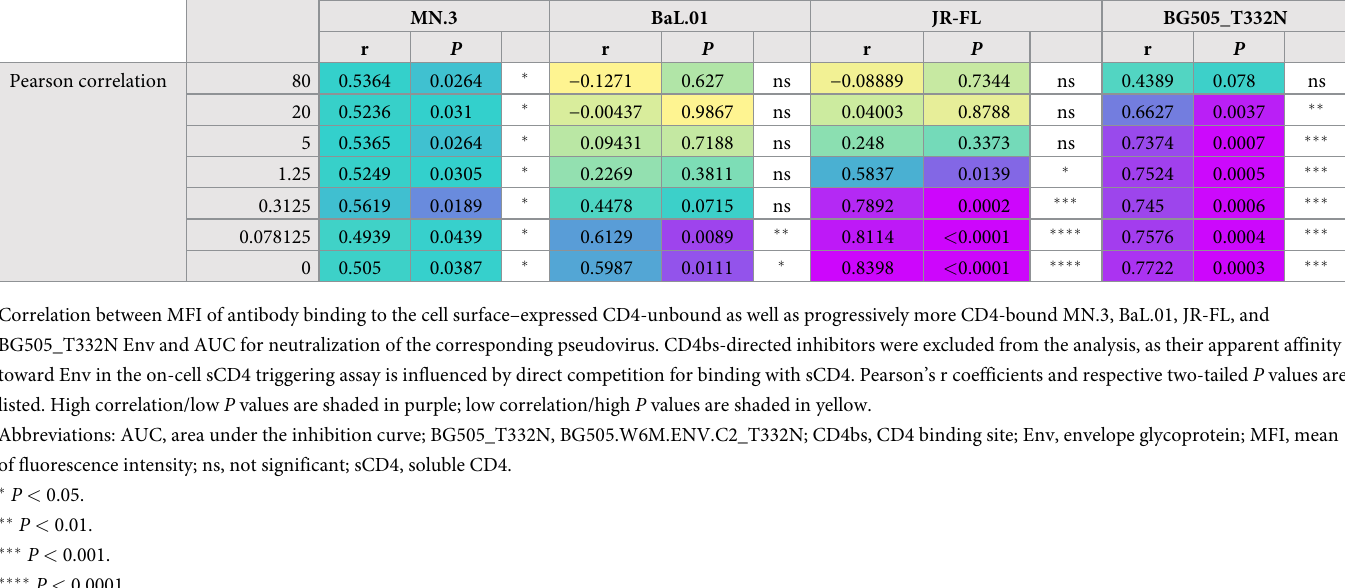
Table 1. Correlation between antibody neutralization and binding to progressively more receptor-triggered forms of the same HIV-1 Env. sCD4 [ μ M]